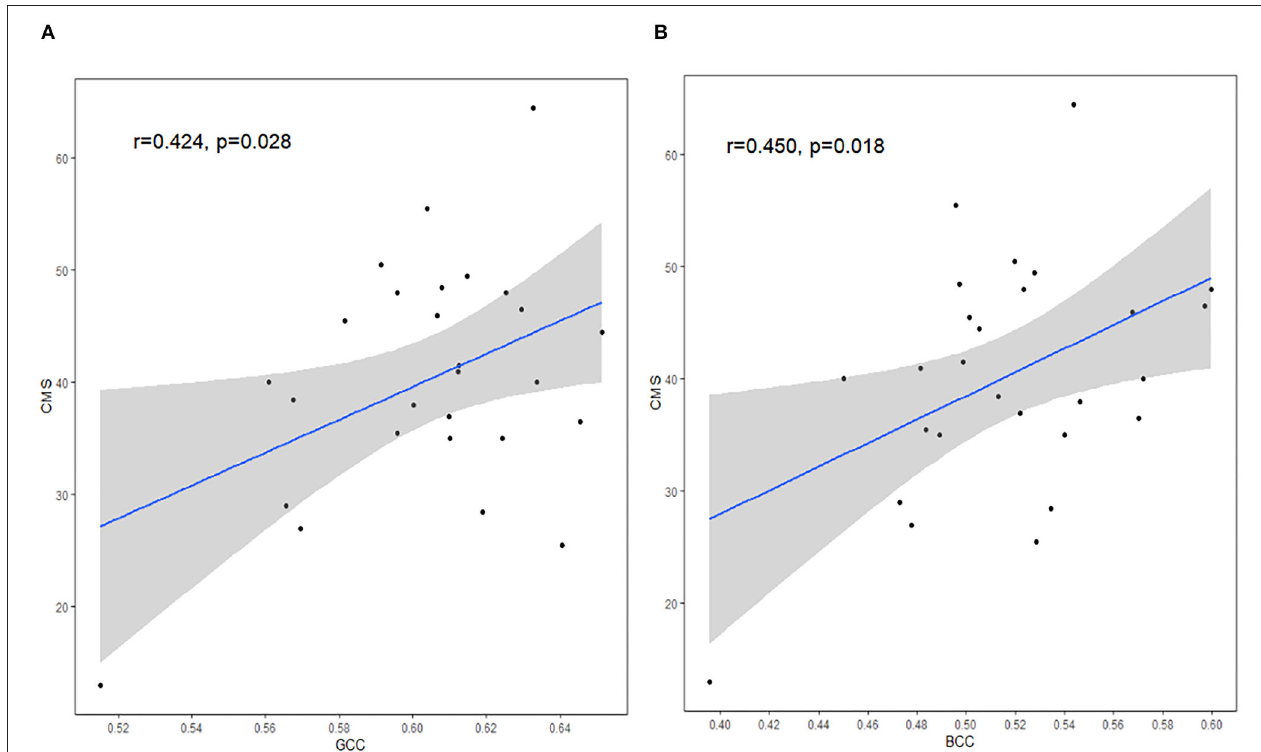
FIGURE 4 | The correlation between DTI measures and CMS. FA in GCC (A) and FA in BCC (B) were positively correlated with CMS scores. GCC, genu of corpus callosum; BCC, body of corpus callosum; CMS, complex motor skills. The shaded area shows its 95% confidence interval. Significance level, p <